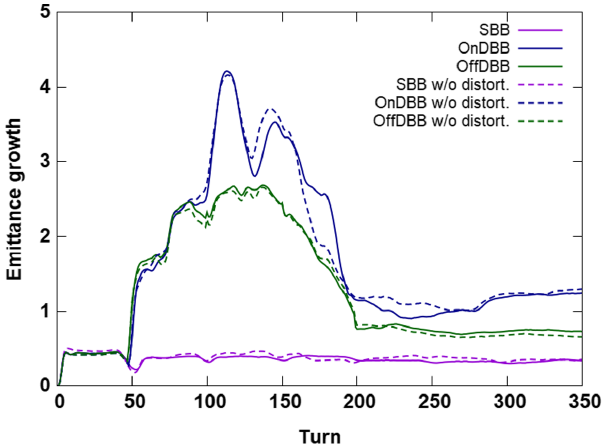
FIG. 14. Evolution of the longitudinal emittance growths in the SBB, onDBB, and offDBB with (solid lines) and without (dashed lines) bucket fluctuations caused by impedance mismatch and the technical